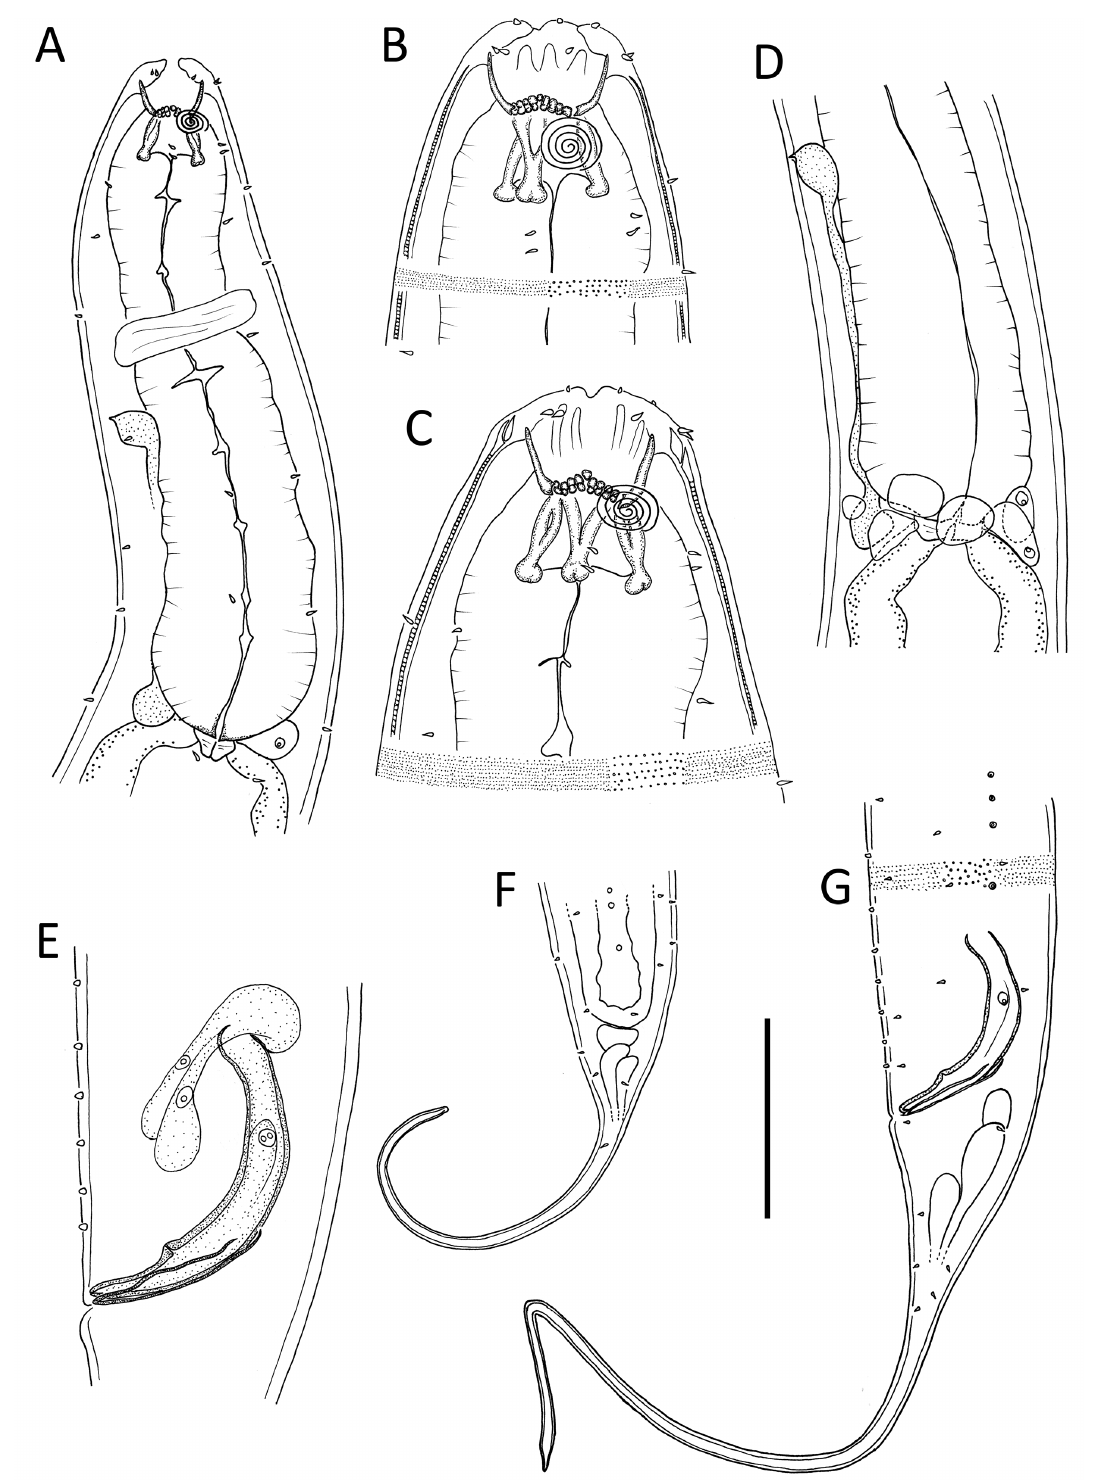
Fig. 7. Halichoanolaimus funestus sp. nov. A . Anterior body region of paratype ♀ (NIWA 139249). B . Holotype ♂ (NIWA 139248), cephalic region. C . Paratype ♀, cephalic region. D . Holotype ♂, posterior pharyngeal region and anterior intestinal region showing location of pseudocoelomocytes. E . Holotype ♂, spicular apparatus. F . Paratype ♀, posterior body region. G . Holotype ♂, posterior body region. Scale bar: A = 112 µm; B–C, E = 50 µm; D = 105 µm; F = 115 µm; G = 75